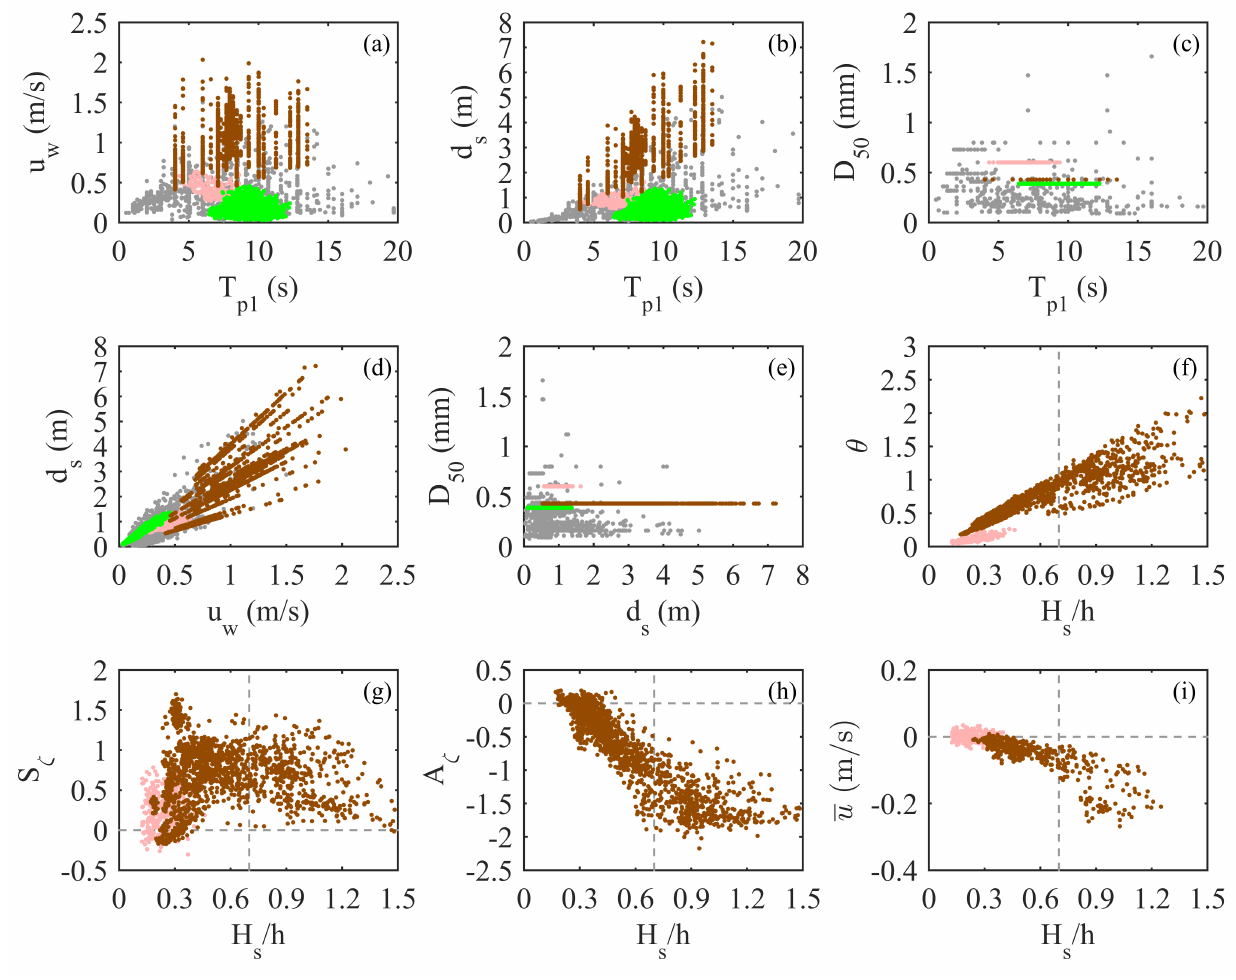
Figure 4. Visualization of the range in local forcing conditions, expressed as two-dimensional scatter plots involving the peak period T , significant wave orbital diameter p 1 d /h , Shields , peak semi-orbital velocity u , median grain size D , relative wave height H s w 50 s parameter θ , skewness S , asymmetry A and the mean cross-shore flow u . Brown dots: ζ ζ Bardex II data; grey dots: Goldstein et al. [6]; light-red dots: Masselink et al. [7]; green dots: Nelson and Voulgaris [38]. The vertical dashed line in ( f )–( i ) delineates the shoaling /h < 0 . 7 ) from the surf zone ( H /h ≥ 0 . 7 zone ( H s s